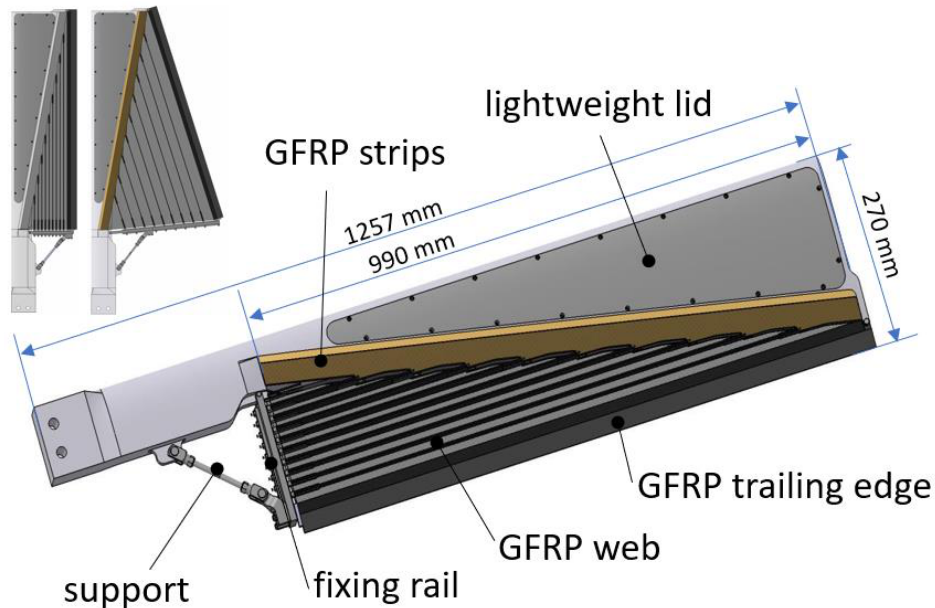
Figure 2. Components of the chord-morphing demonstrator and description of the individual components. Upper left corner: 0% and 100% chord morphing state of the demonstrator in whirl tower configuration.